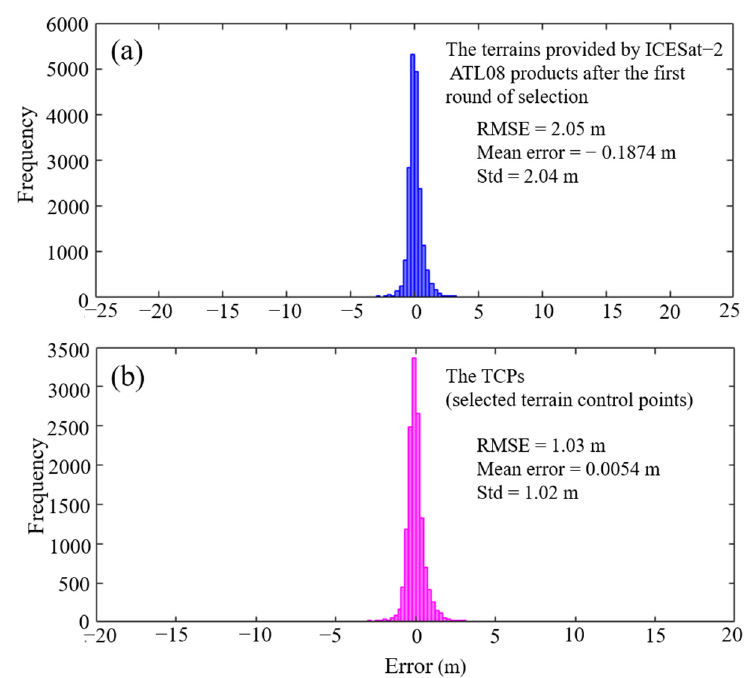
Figure 3. ( a ) Histogram of elevation differences between the terrain models provided by ICESat-2 ATL08 products and the reference DTM; and ( b ) histogram of errors between the TCPs and the reference DTM.